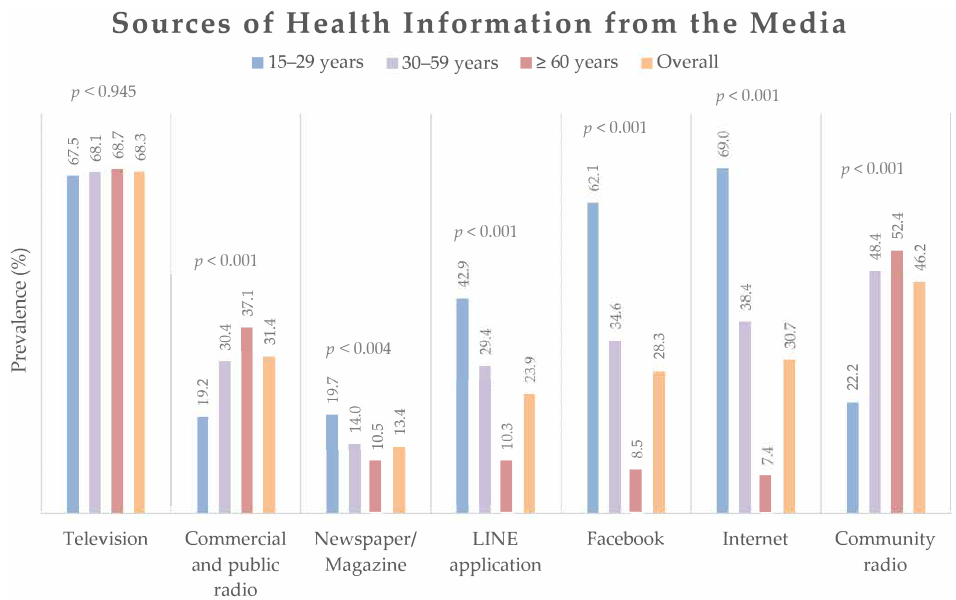
Figure 3. Sources of health information obtained from media overall and by age group. The differ- ences in prevalence of received health information from the media among age-groups were analyzed by chi-square